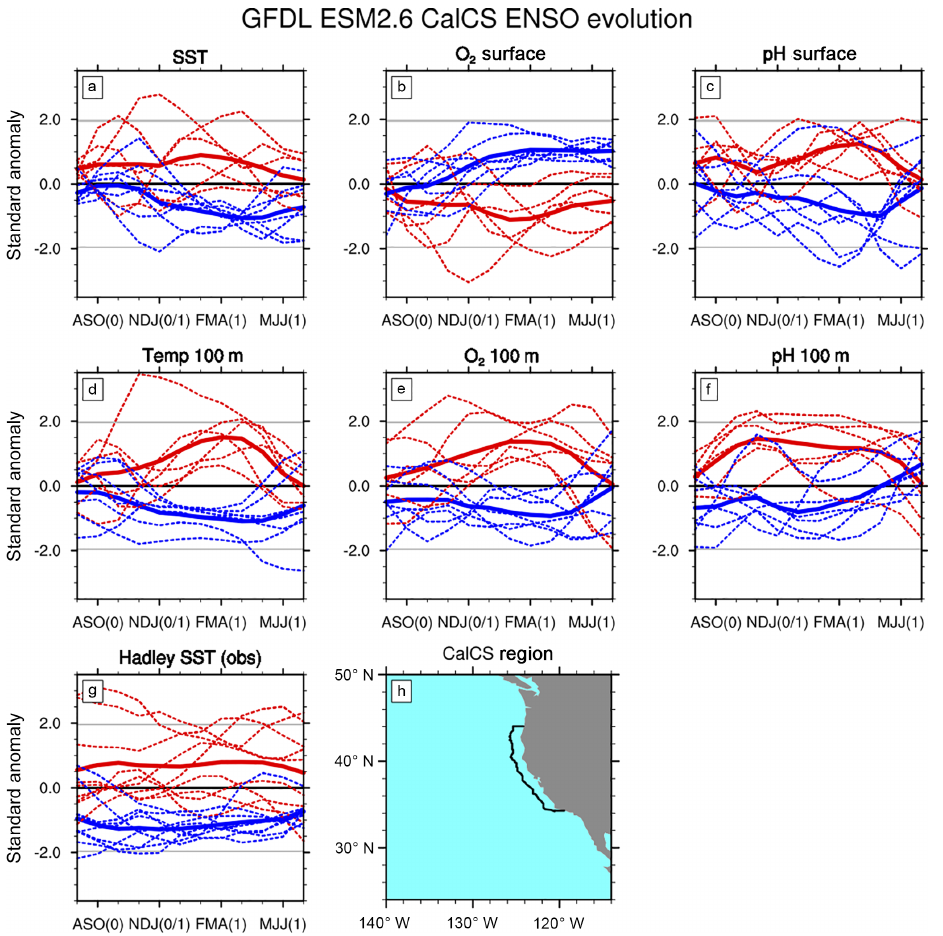
Figure 5. Temporal evolution of individual warm (red) and cold (blue) events (dashed) and composite of all events (solid) for area averages between 34 and 44 ◦ N and 100km offshore of the US west coast for (a) ESM2.6 sea surface temperature, (b) ESM2.6 surface O 2 , (c) ESM2.6 surface pH, (d) ESM2.6 100m temperature, (e) ESM2.6 100m O 2 , (f) ESM2.6 100m pH, and (g) HadISST sea surface temperature. The time series are high-pass filtered and seasonally averaged and show the evolution of standardized anomalies (unitless) during the peak ENSO years from July–August–September (JAS) before the peak to June–July–August (JJA) after the peak. The black outline in panel (h) highlights the area within the CalCS used for this analysis. The notation of 0 / 1 is as used in Rasmusson and Carpenter